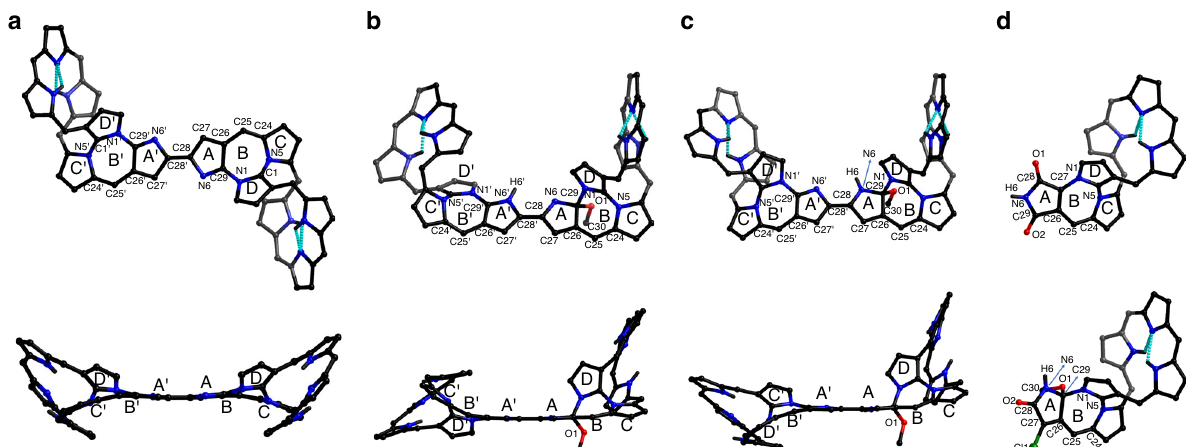
Fig. 3 Crystal structures of the dimers and monomers considered in this study. Complementary views of the molecular structures of D ( a ), MD1 ( b ), and MD2 ( c ) and molecular structures of FHPO 2 ( d , top) and FHPMOCl ( d , bottom). Penta fl uorophenyl substituents, solvents, and the hydrogen atoms attached to the carbon atoms are omitted for clarity. The dotted lines represent intramolecular hydrogen bonds inferred on the basis of the metric parameters. N, O, and Cl atoms are denoted with balls of blue, red, and green colors, respectively. C and H atoms (linked to N atoms) are denoted with black balls, with smaller balls used for the